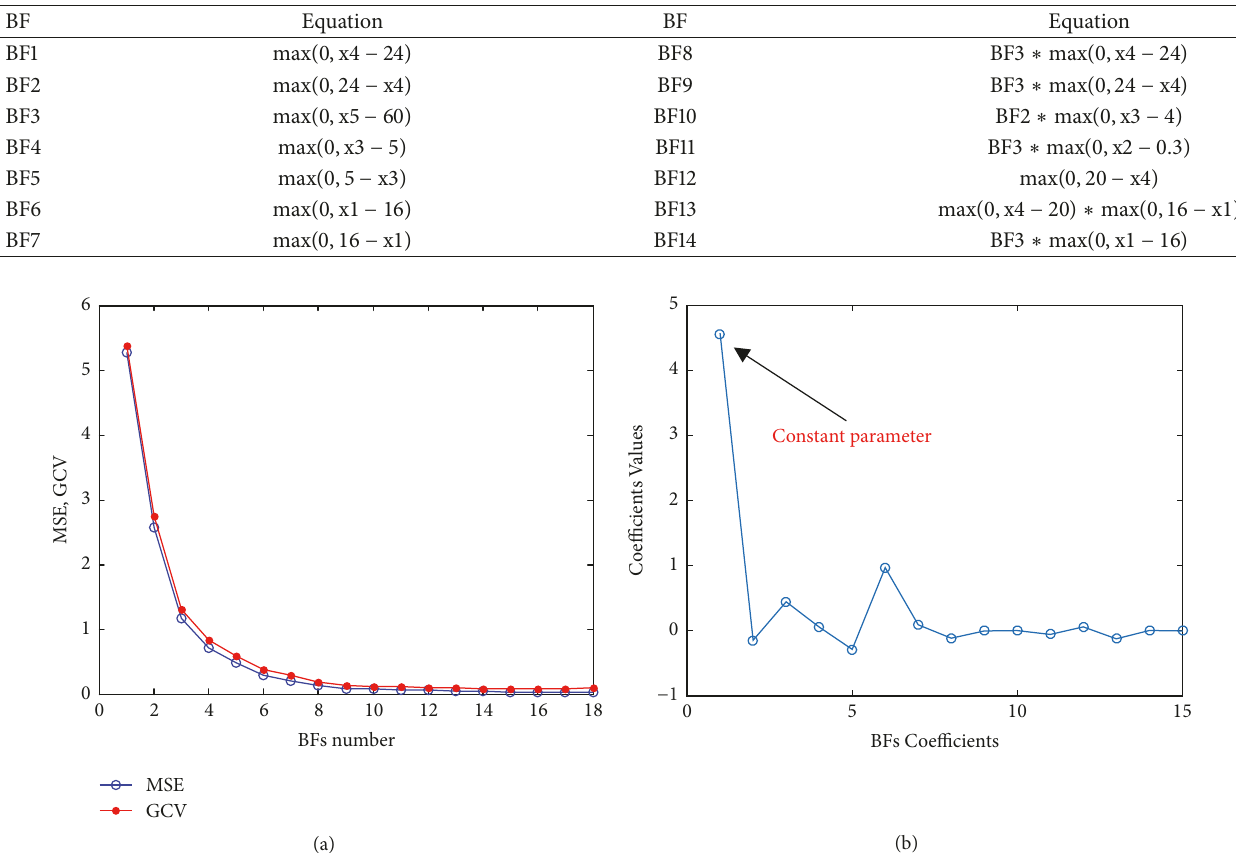
Table 3: Basis functions and corresponding equations of MARS model for settlement.